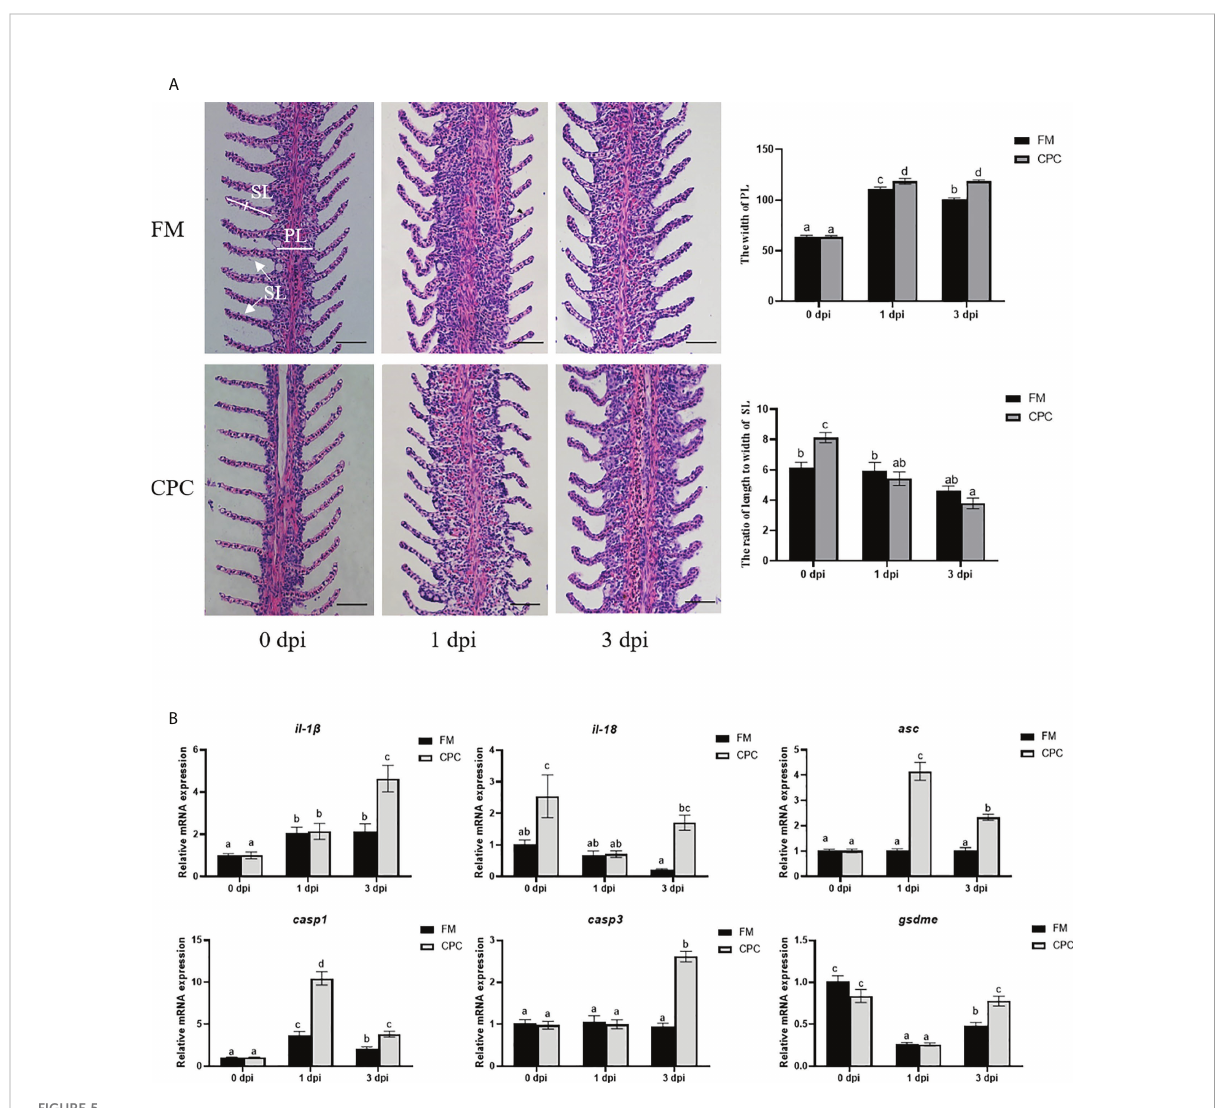
FIGURE 5 Higher in fl ammatory responses were induced in gill of largemouth bass fed with CPC after N. seriolae infection. (A) The H.E. staining results of juvenile largemouth bass gill fed with FM and CPC at different days post N. seriolae infection (dpi). PL: primary gill lamella; SL: secondary gill lamella. Scale bars, 50 m m. (B) The relative mRNA expression levels of genes involved in in fl ammation and pyroptosis ( il-1 b , il-18, asc, casp1, casp3 and gsdme ) in the gill of largemouth bass fed with FM and CPC at different days post N. seriolae infection (dpi). All data was analyzed with two-way ANOVA and data are means ± SD (n = 6). Mean values with different letters indicated signi fi cant difference among groups, P <